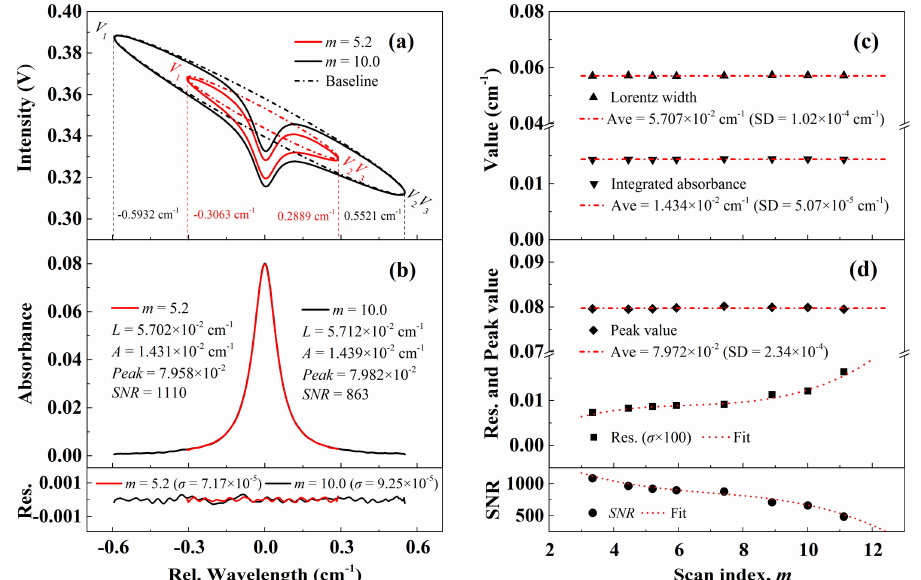
Figure 7. Recovered light intensity ( a ) and the best-fit absorbance ( b ) with scan indexes of 5.3 and 10. ( c , d ) The best-fit parameters including the Lorentz width, integrated area, peak value, standard deviation of residual and SNR with di ff erent scan indexes. The experimental conditions are: CO / N 2 mixture gas, T = 299 K, L = 14.7 cm, Xco = 1.53%, P = 100.6